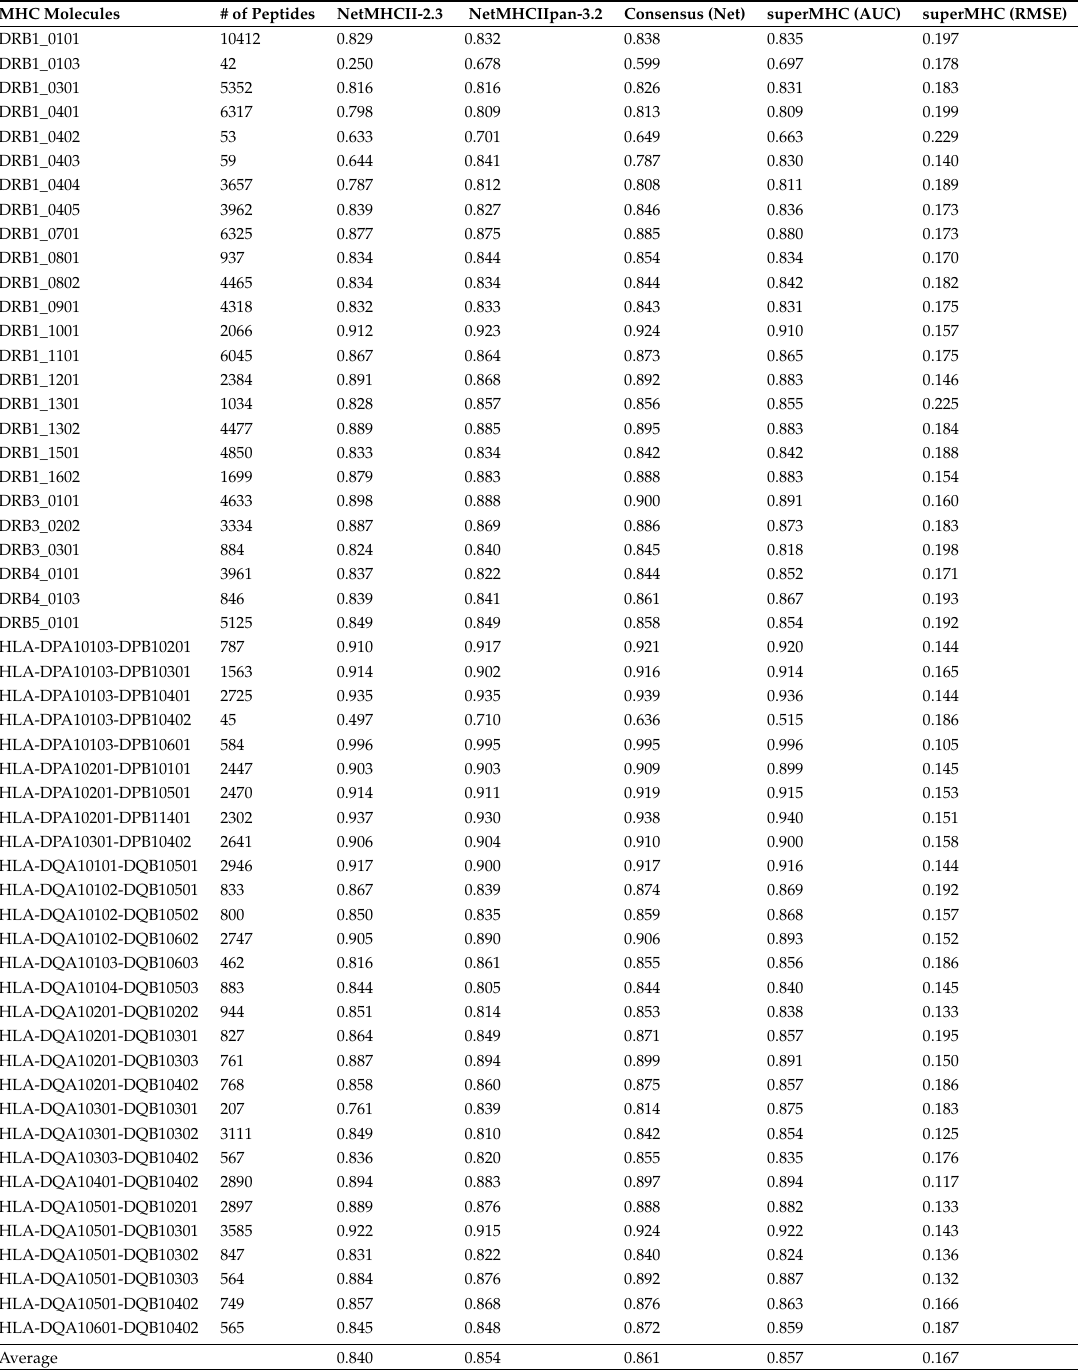
Table 3. The performance of superMHC in comparison with NetMHCII-2.3, NetMHCIIpan-3.2, and their consensus method on the NetMHCIIpan-3.2 dataset in terms of AUC. MHC Molecules # of Peptides